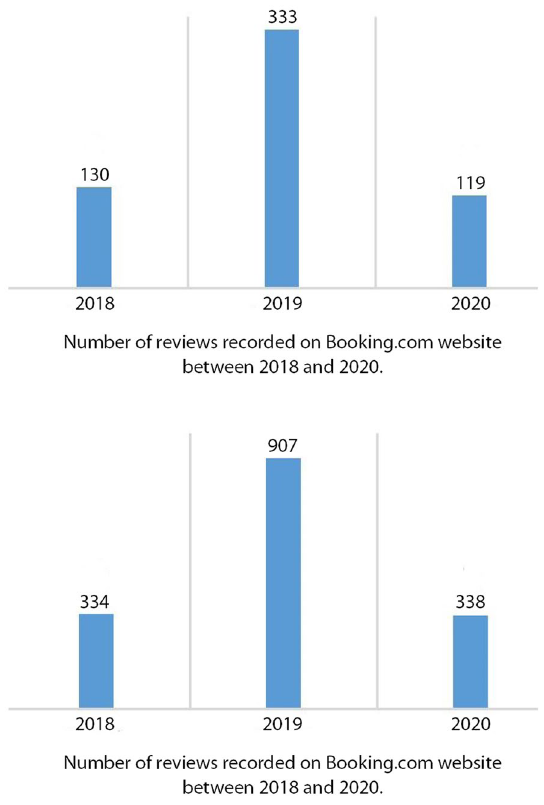
Fig. 6 Number of customers in Misfat Old House (2018–2020) (Source: the author, based on Booki ng. com